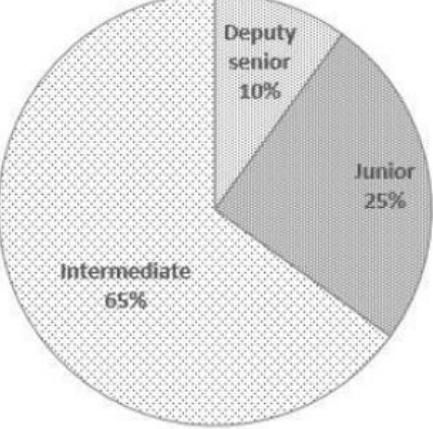
Figure 1. Professional titles of experts.